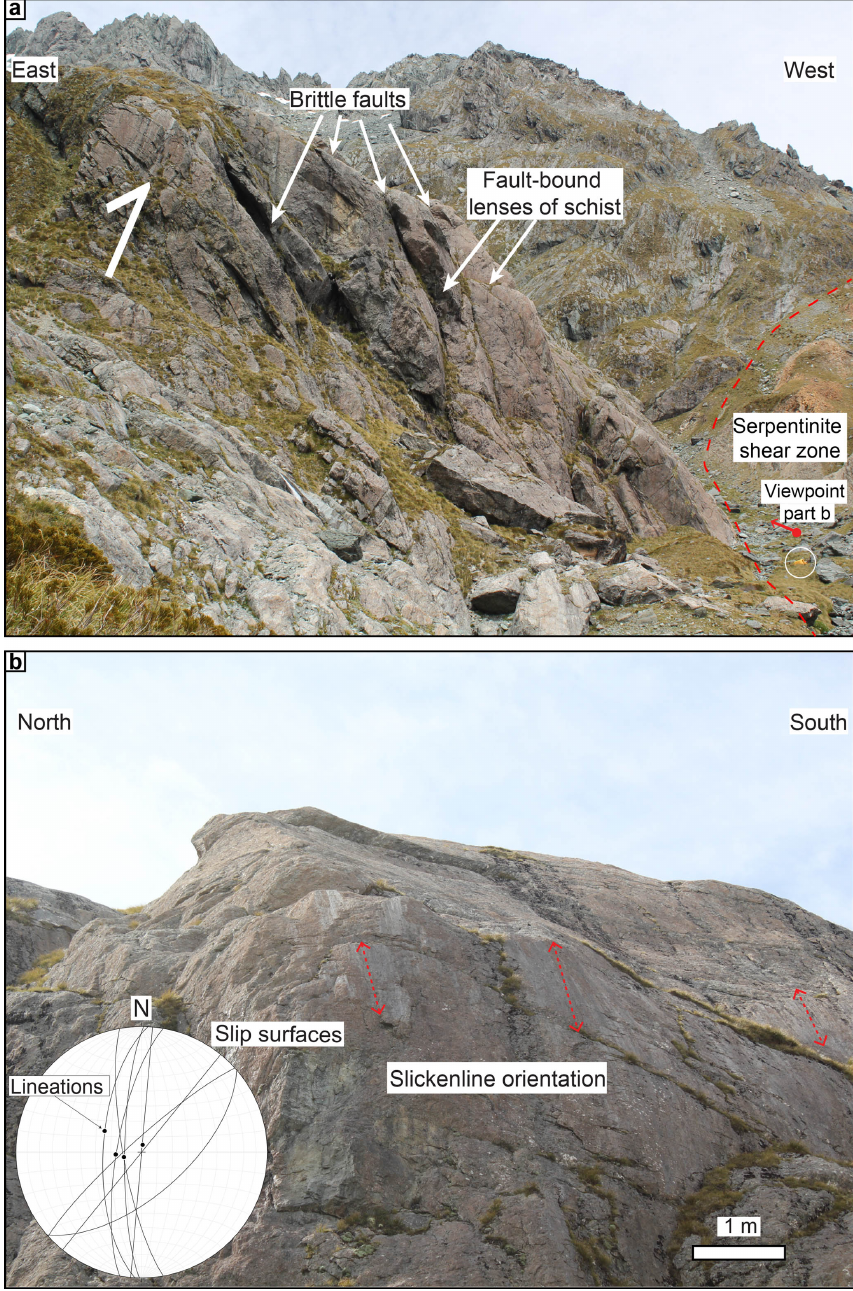
Figure 4. Deformation in the Caples–Aspiring Terrane wall rocks at Fiery Col and Cow Saddle. (a) Photo looking south from Fiery Col towards Cow Saddle (location shown in Fig. 3c). Schists adjacent to the eastern boundary of the serpentinite shear zone are cut by linked arrays of brittle faults that surround large lenses of metasomatised and fractured schist. Tent for scale circled in white. (b) The brittle faults are characterised by polished slickensides with lineations and cataclastic slip zones. The stereonet (lower hemisphere, equal area) shows the orientations of eight fault surfaces with associated steeply plunging